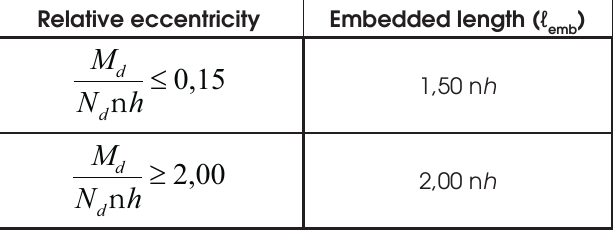
Embedded length of column (adapted from ABNT NBR 9062:2006 [9]) Relative